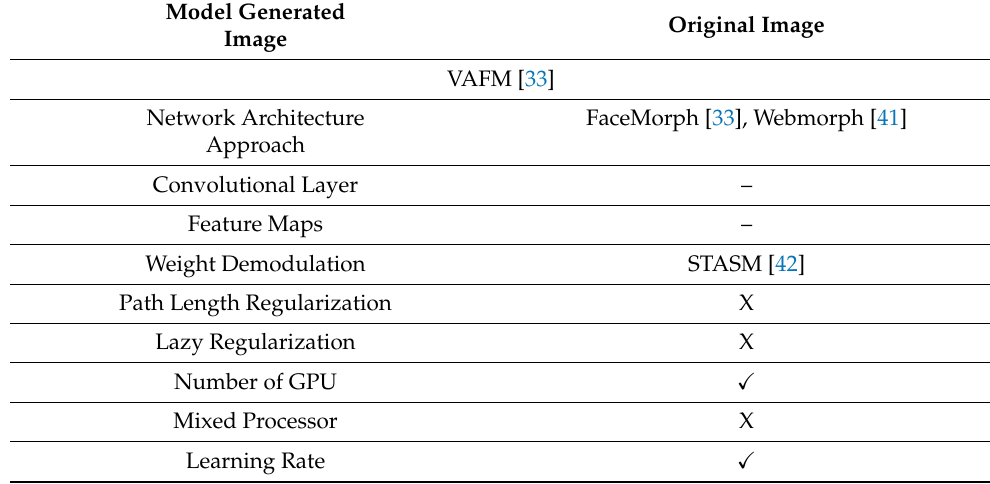
Table 8. Comparison of the proposed model with VAFM [33].